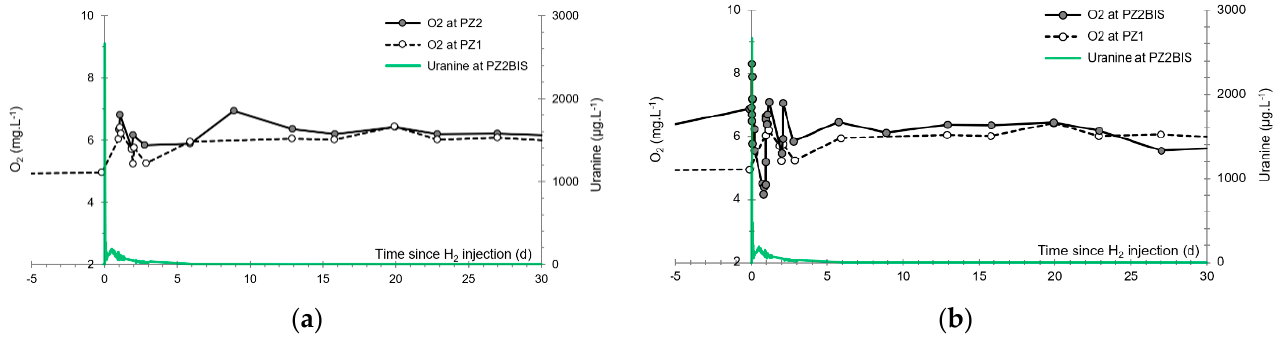
Figure 17. Comparative evolution of the dissolved oxygen and the tracer concentrations at the main piezometers: ( a ) PZ1